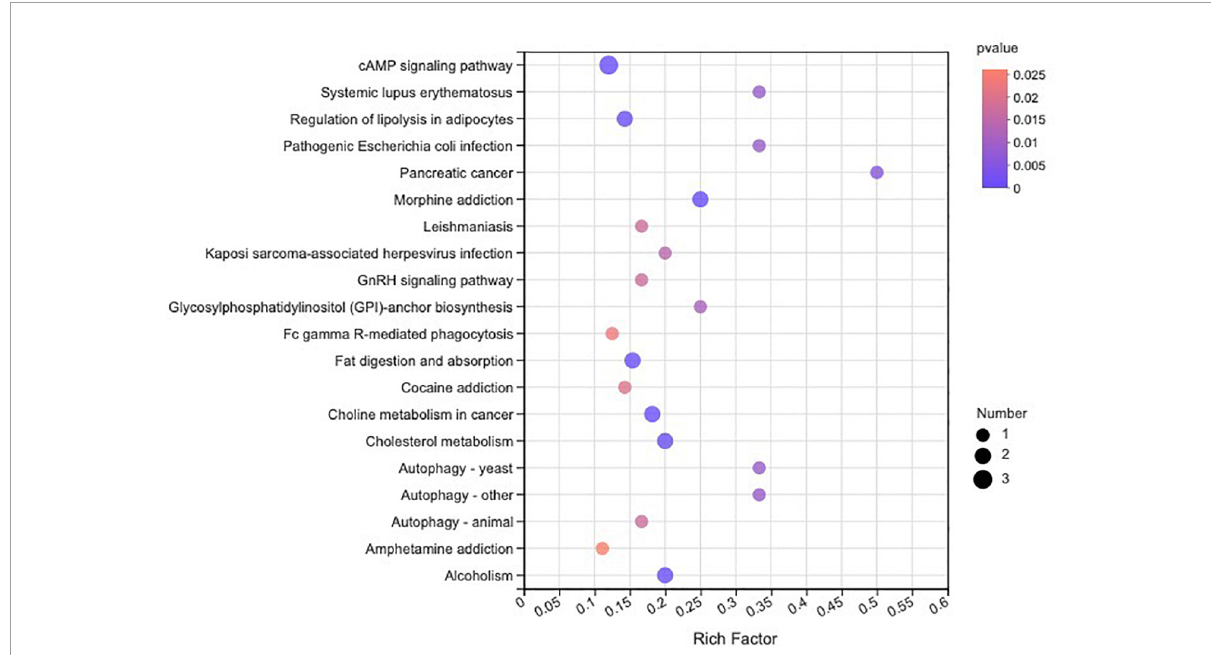
FIGURE7 Kyoto Encyclopedia of Genes and Genomes pathway enrichment analysis for differentially accumulated metabolites in sainfoin silage.